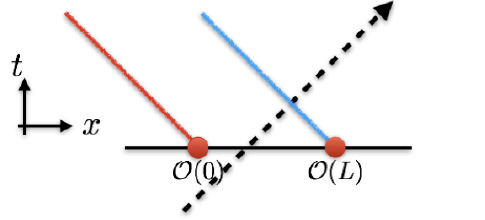
Figure 9 . When null geodesic crosses with null blue line, ANE changes by (cid:0) 4 (cid:25)gh null red line. In particular, when 0 < a < 0, averaged null energy is (cid:0) 4 (cid:25)gh